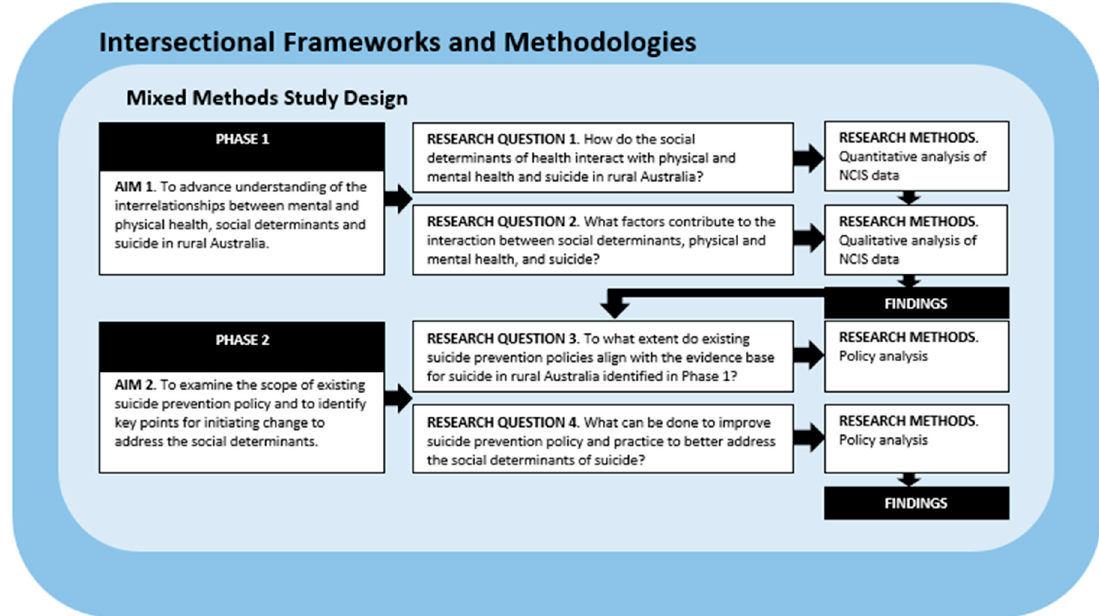
Figure 1. Flow of research aims and questions to methods.